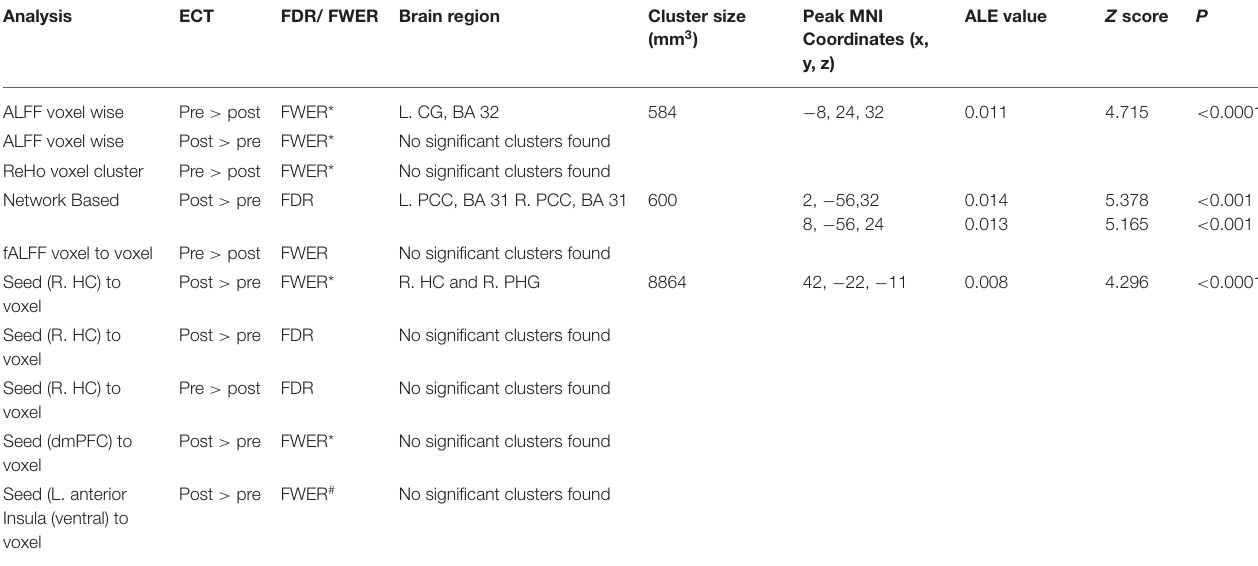
TABLE 3 | ALE results for studies using different measures of rsFC to study the effect of ECT in depression.